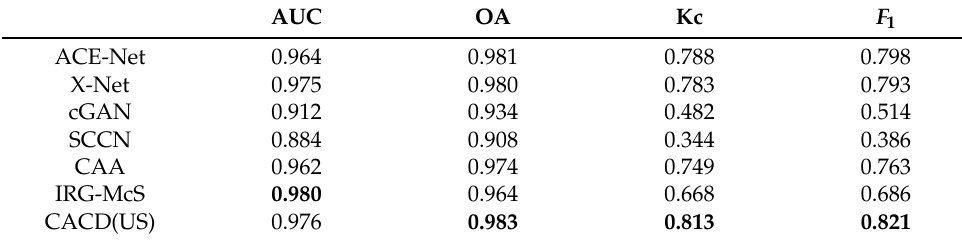
Table 2. Quantitative evaluation on the Shuguang